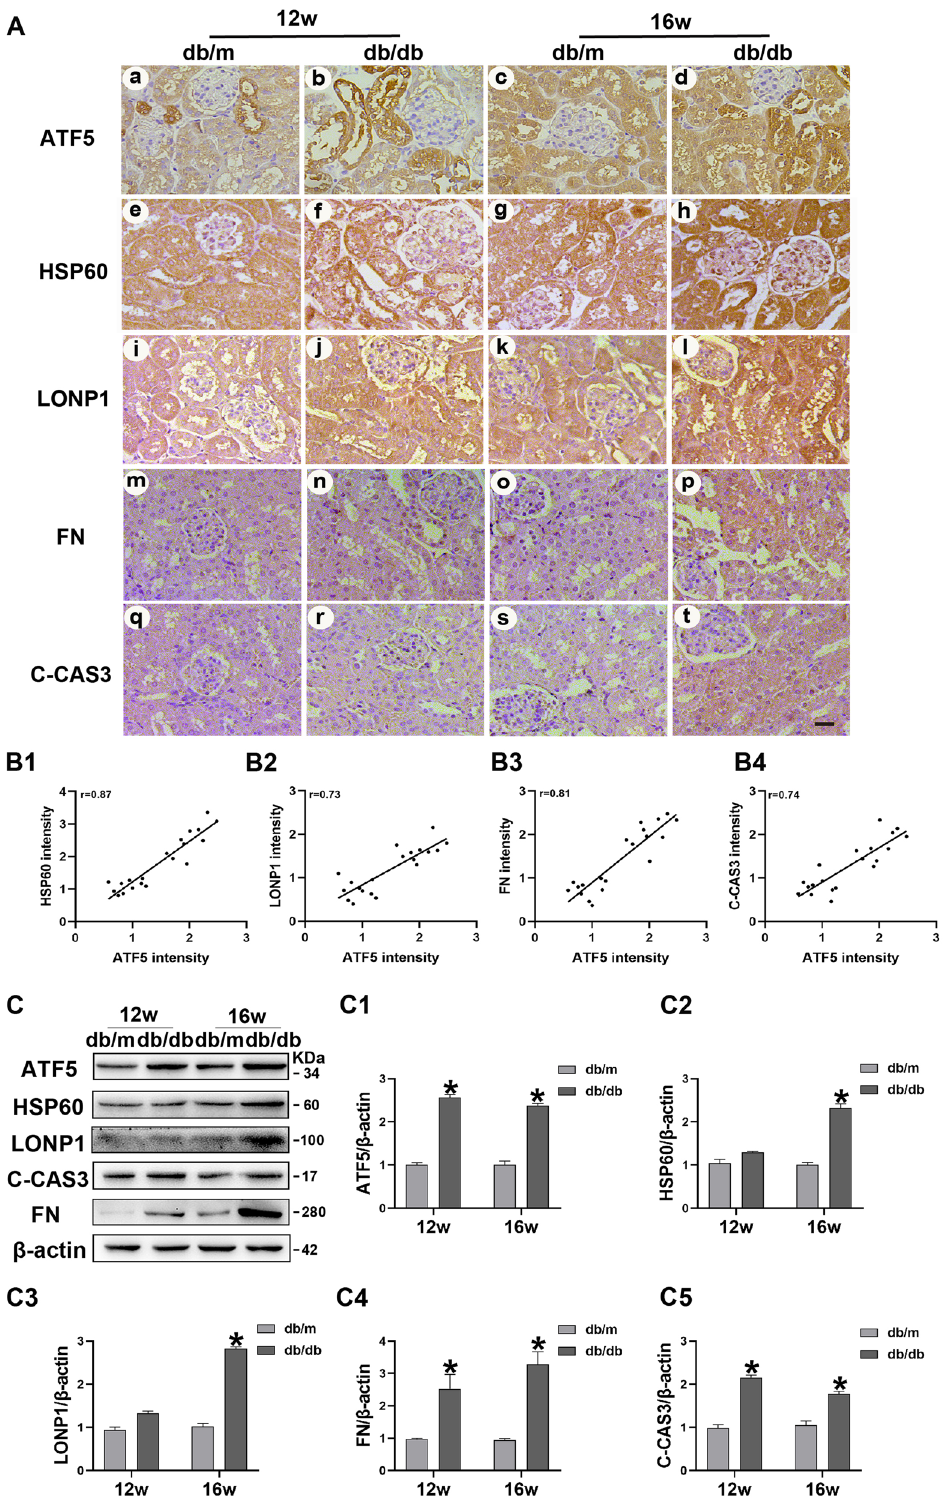
Fig. 2 Increased ATF5/HSP60/LONP1 expression in the kidneys of db/db mice and the correlation with tubular damage. A IHC staining of ATF5, HSP60, LONP1, FN and C-CAS3 in the kidney sections of 12/16-week-old db/db mice. Scale bar: 30 μm. B1–B4 The correlations of HSP60, LONP1, FN, C-CAS3 with ATF5 expression in the kidney of db/db mice. C Western blot analysis of ATF5 and HSP60, LONP1, FN, C-CAS3 in mice kidney tissue. C1–C5 Relative band density. All data are presented as means SD; *p < 0.05 vs db/m. r: correlation coefficient. n ± =